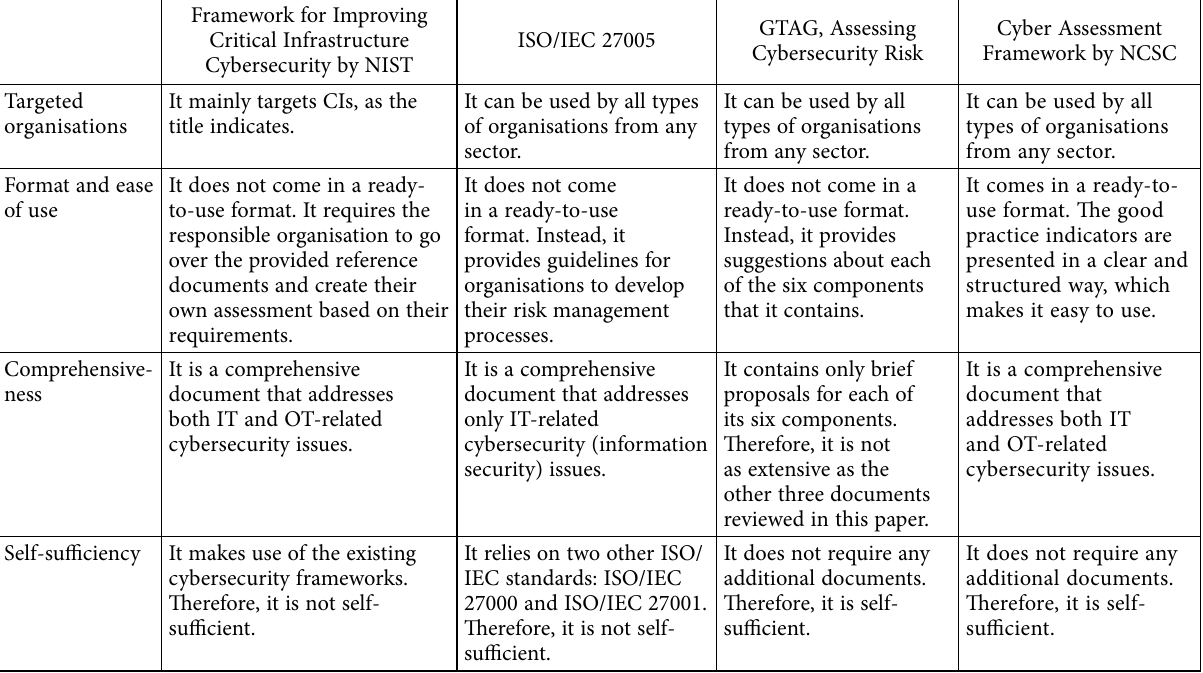
Table 2. Comparison between the reviewed cybersecurity